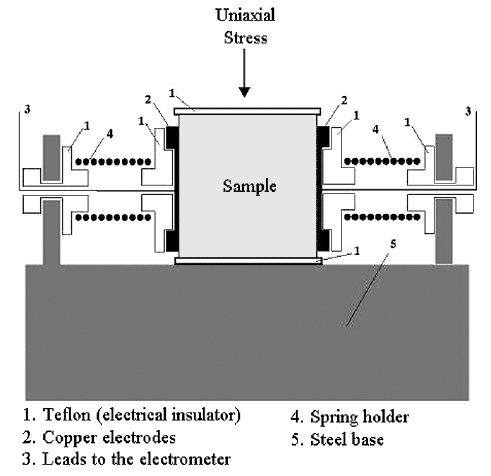
Fig. 1. Experimental setup.